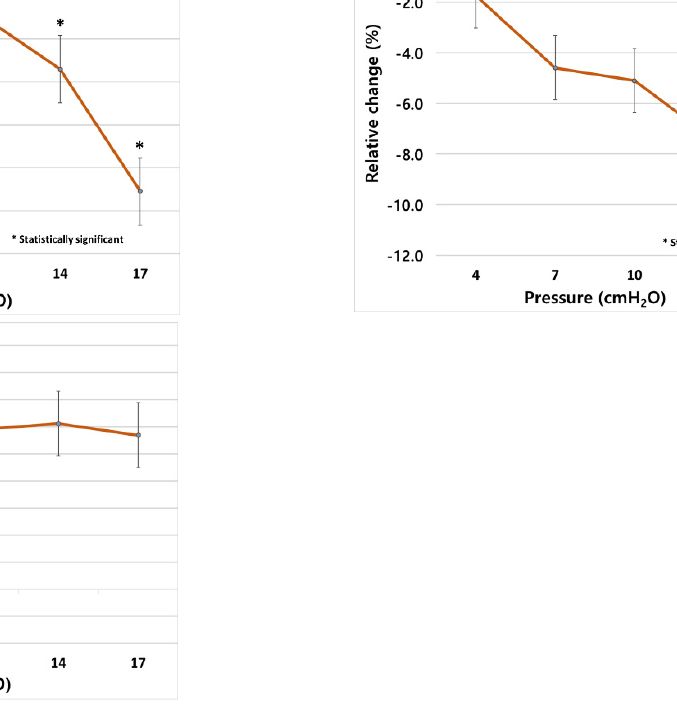
mean , ( B ) V5, and ( C )